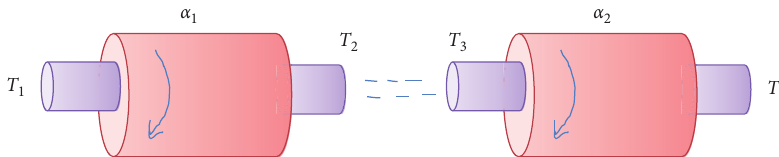
Figure 7: Connected rotating